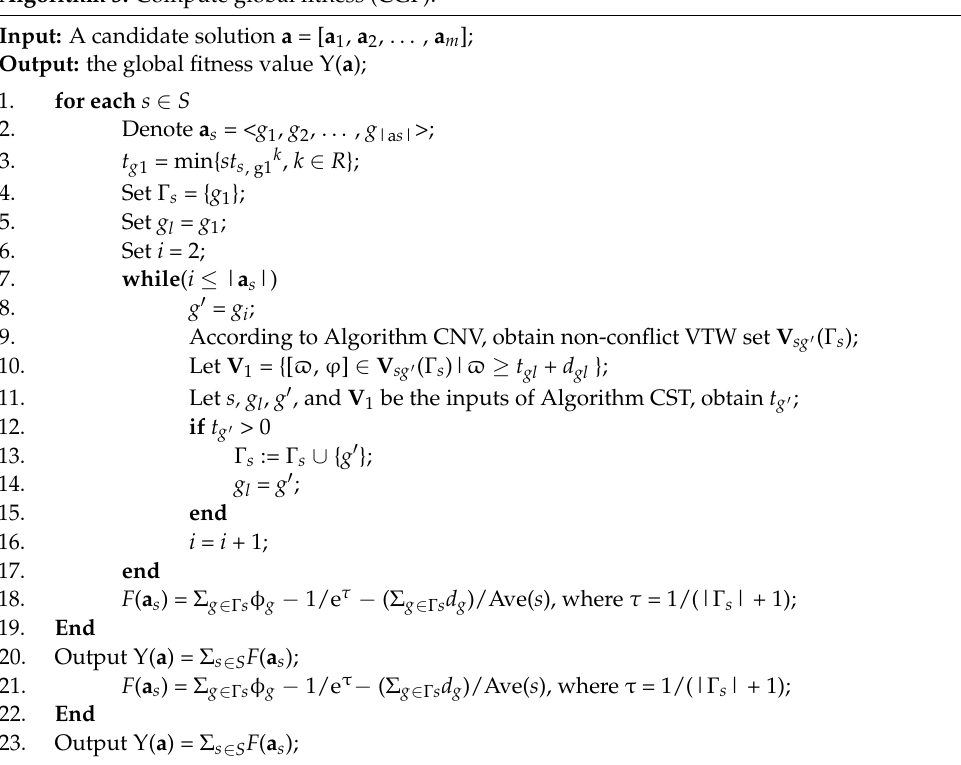
Algorithm 3: Compute global fitness